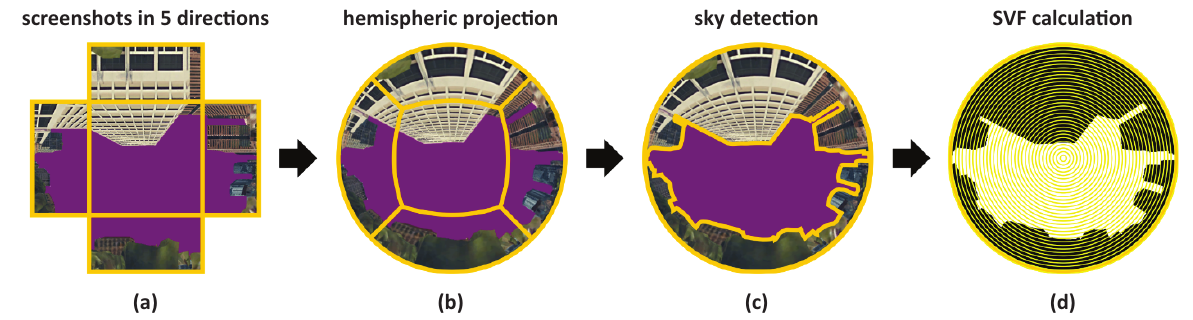
Figure 1. Sky View Factor calculation pipeline. Starting with five images of 90° field of view (a), we apply an angular hemi- spheric fisheye projection (b), detect sky regions (c), and calculate the Sky View Factor using 36 annular rings (d).